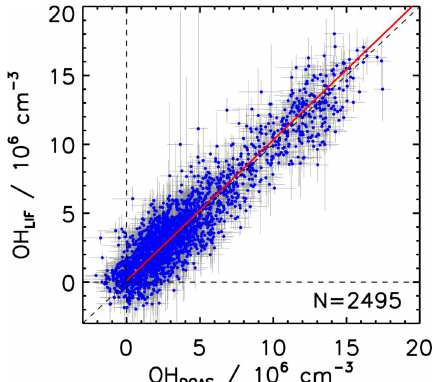
Fig. 4. Correlation of all OH concentration measurements by DOAS and LIF during SAPHIR experiments in summer 2011. LIF data are averaged to the time resolution of DOAS measure- ments. Grey bars are 1 σ errors of measurements. The red line gives the result of the regression analysis (slope: 1.02 ± 0.01, intercept (0.10 ± 0.03) × 10 6 cm − 3 , R 2